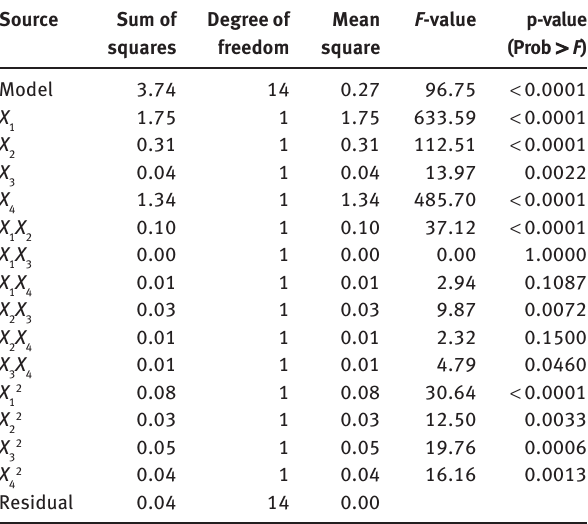
Table 5: Analysis of variance for response surface model of dehydration rate.